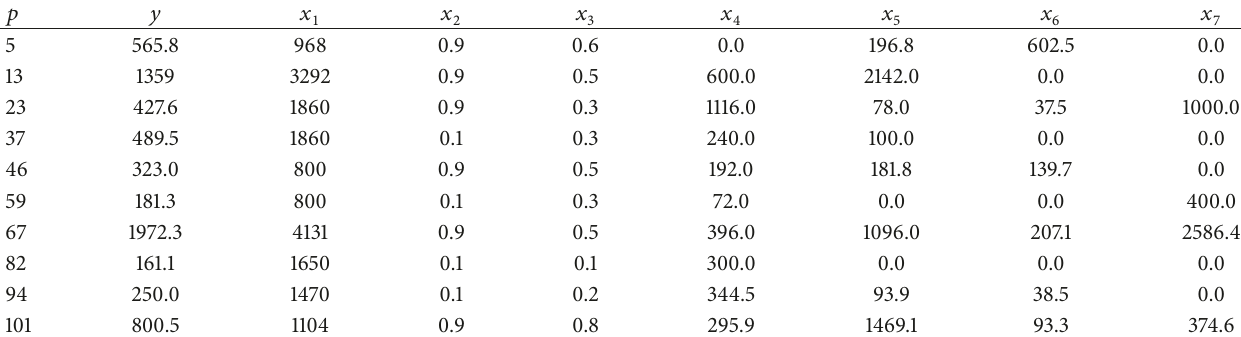
Table 4: Exemplary records of the database including training patterns (source: own study).